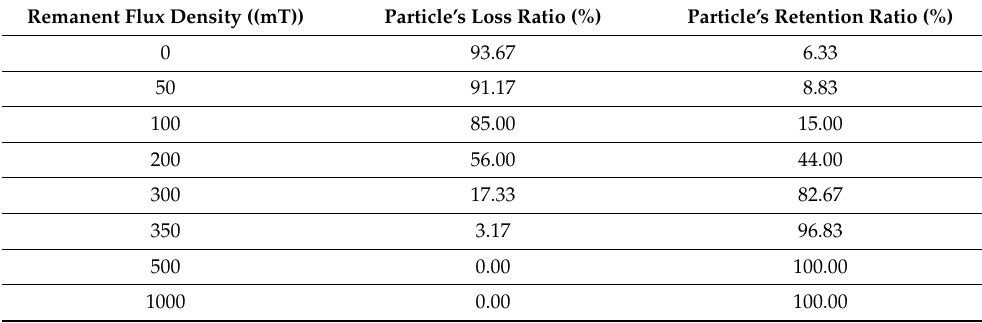
Table 1. Retention ratio analysis at the microreactor’s outlet after 30 s of